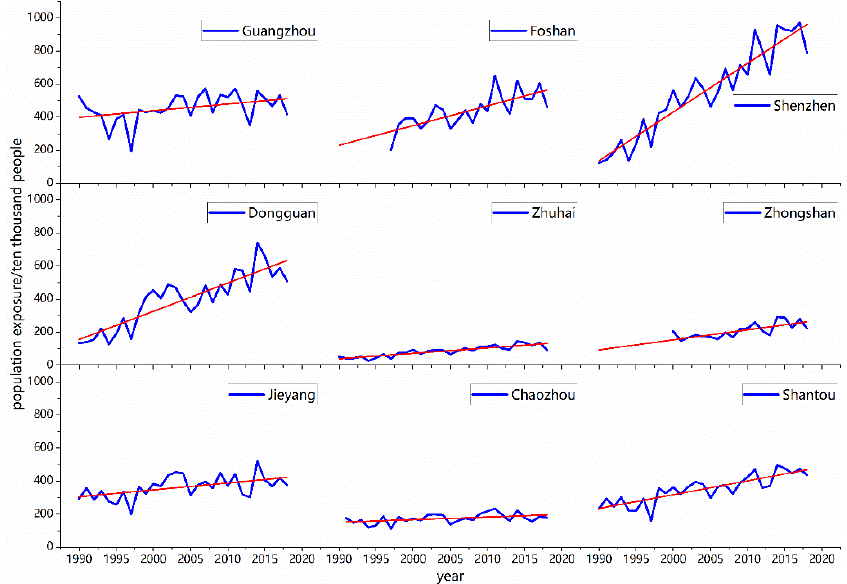
Figure 7. PST (red line) and corresponding linear trend (blue line) during summer 1990 to 2018. Notes: All reach a significance level of 0.05.